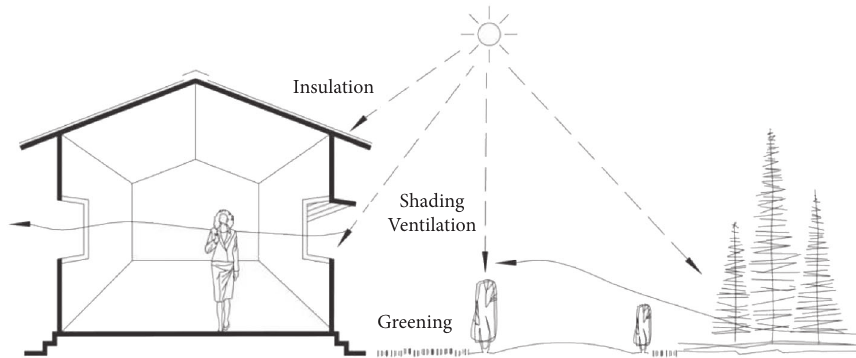
Figure 2: Schematic diagram of comprehensive heat protection planning for farmhouses. Chart source: the authors, organized according to relevant